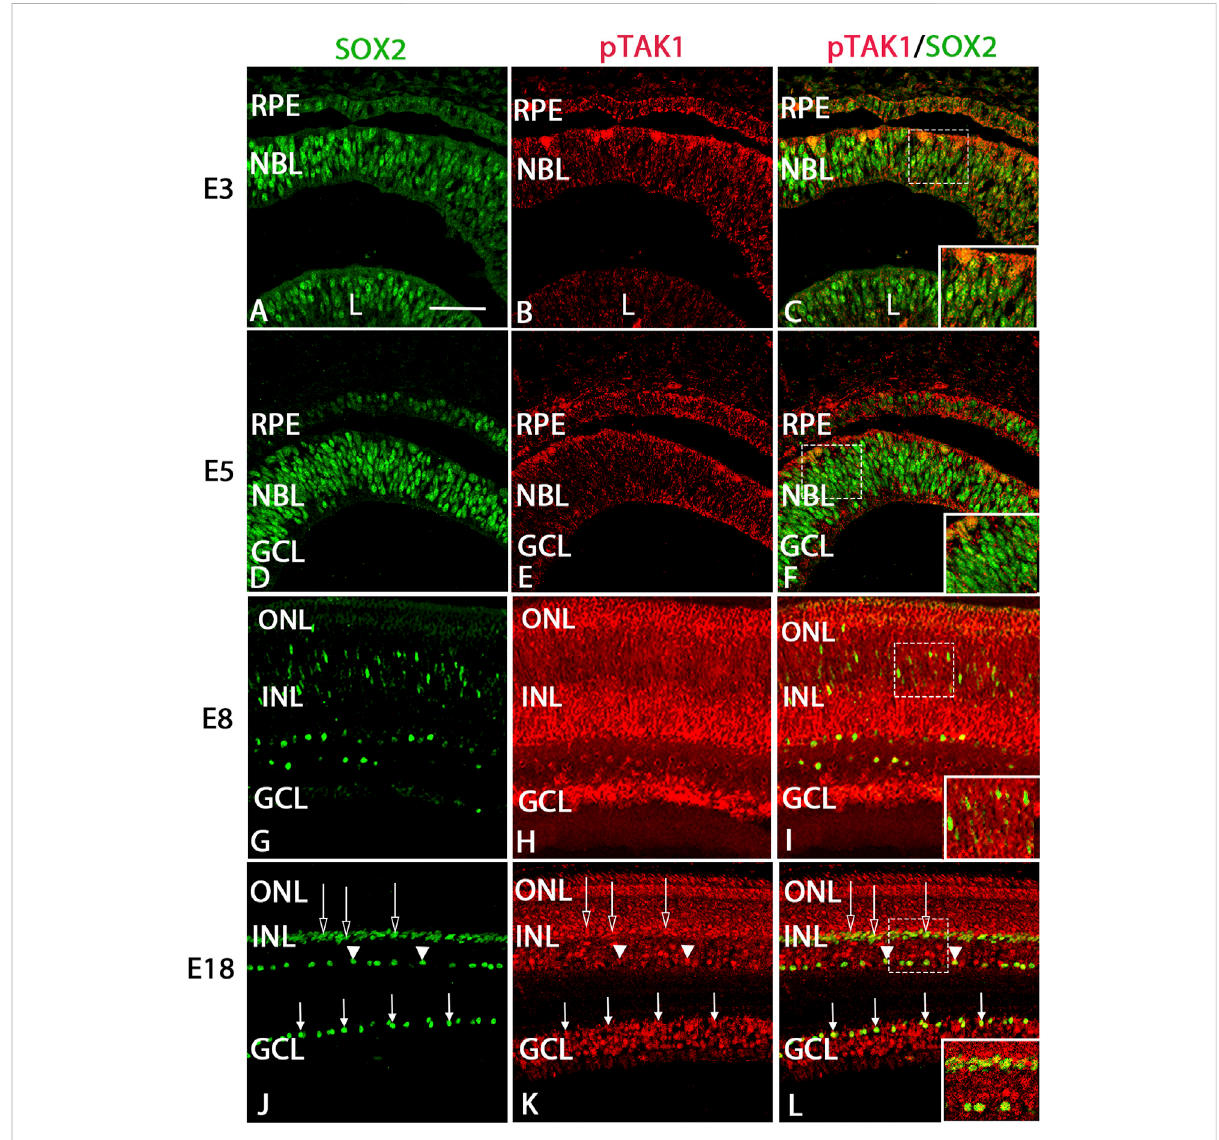
FIGURE 3 pTAK1 was co-localized to SOX2 + retinal progenitors in the early chick retina and a subset of Müller glial, cholinergic amacrine, and astrocyte cells in later stages.Chick retinal sections from E3, E5, E7, and E18 embryos were double labeled for SOX2 (A,D,G,J) and pTAK1 (B,E,H,K) . Co-label is shown in (C,F,I,L) . Open arrows indicated Müller glia, closed arrows indicate retinal astrocytes, and arrowheads indicate cholinergic amacrine cells (J,K,L) . Dashed boxes in (C,F,I,L) are shown at higher magni fi cation in insets in (C,F,I,L) . Abbreviations: RPE, retinal pigmented epithelium; NBL, neuroblast layer; INL, inner nuclear layer; GCL, ganglion cell layer. Scale bar in A = 50 μ m for images (A – L)